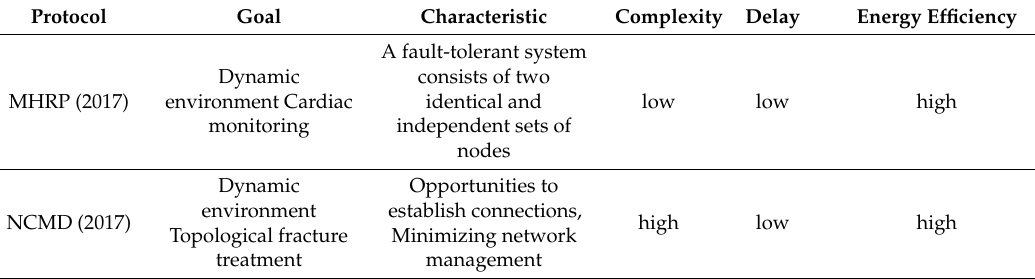
Table 2. Posture-based routing protocols comparison.